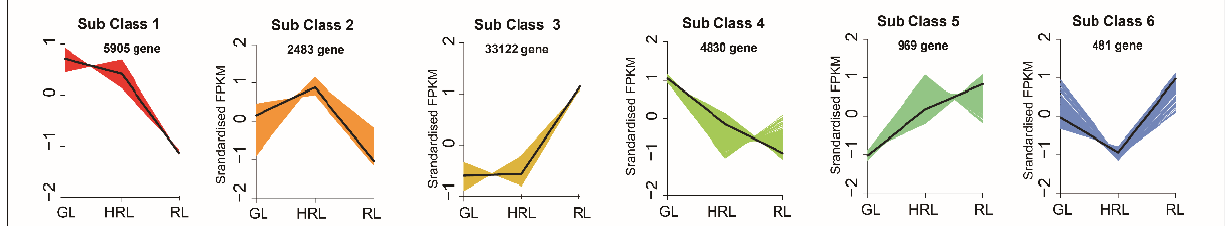
Figure 7. k ‐ means clustering of DEGs. Black lines show the average values for standardized FPKM in each sub ‐ class; the colored lines represent the standardized FPKM values of each gene in each sub ‐ class.